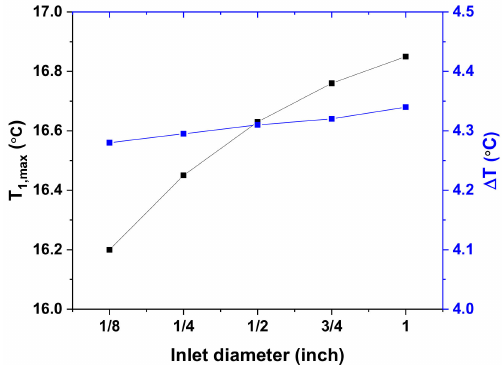
Figure 8. The maximum temperature increment (T 1,max ) and temperature gradient ( ∆ T) on cell surface under cooling with various inlet/outlet